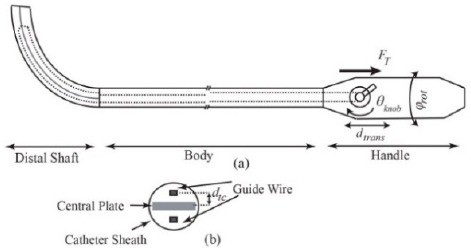
Figure 1. The schematic representation of the ablation catheter: ( a ) Tendons are represented by dashed lines and the central plate (thin plate tendons attached to it) is depicted with solid lines inside the distal shaft. θ knob , ϕ rot and d trans are representing steering knob rotation, handle twist and translation, respectively; ( b ) Cross-section of the distal shaft.